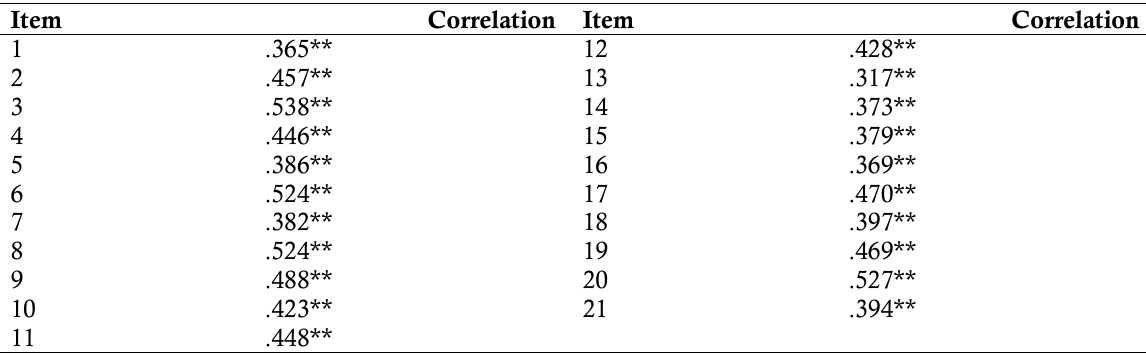
Table 2. The CDSE-SF Items’ correlations with the total score.